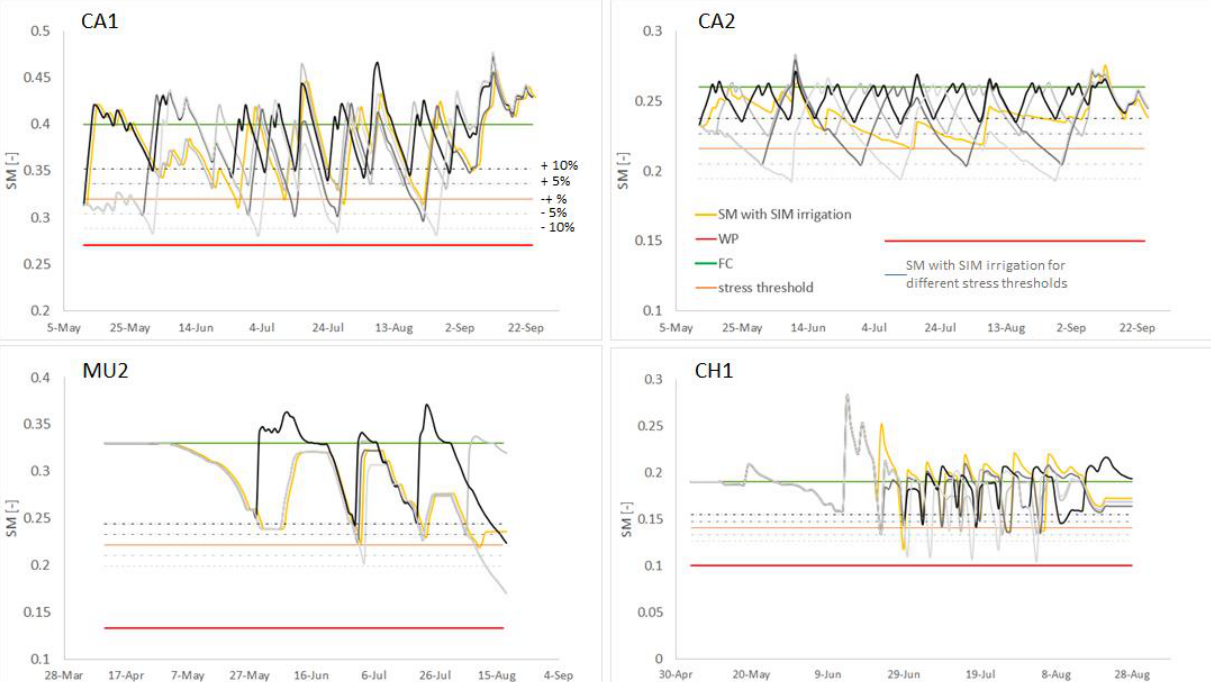
Figure 8. Sensitivity analysis to p value in respect to soil moisture for the two tomato fields (CA1 and CA2) and for the two maize fields (MU2 and CH1). Table 8. Effect of SM stress threshold on irrigation amount and crop yield.